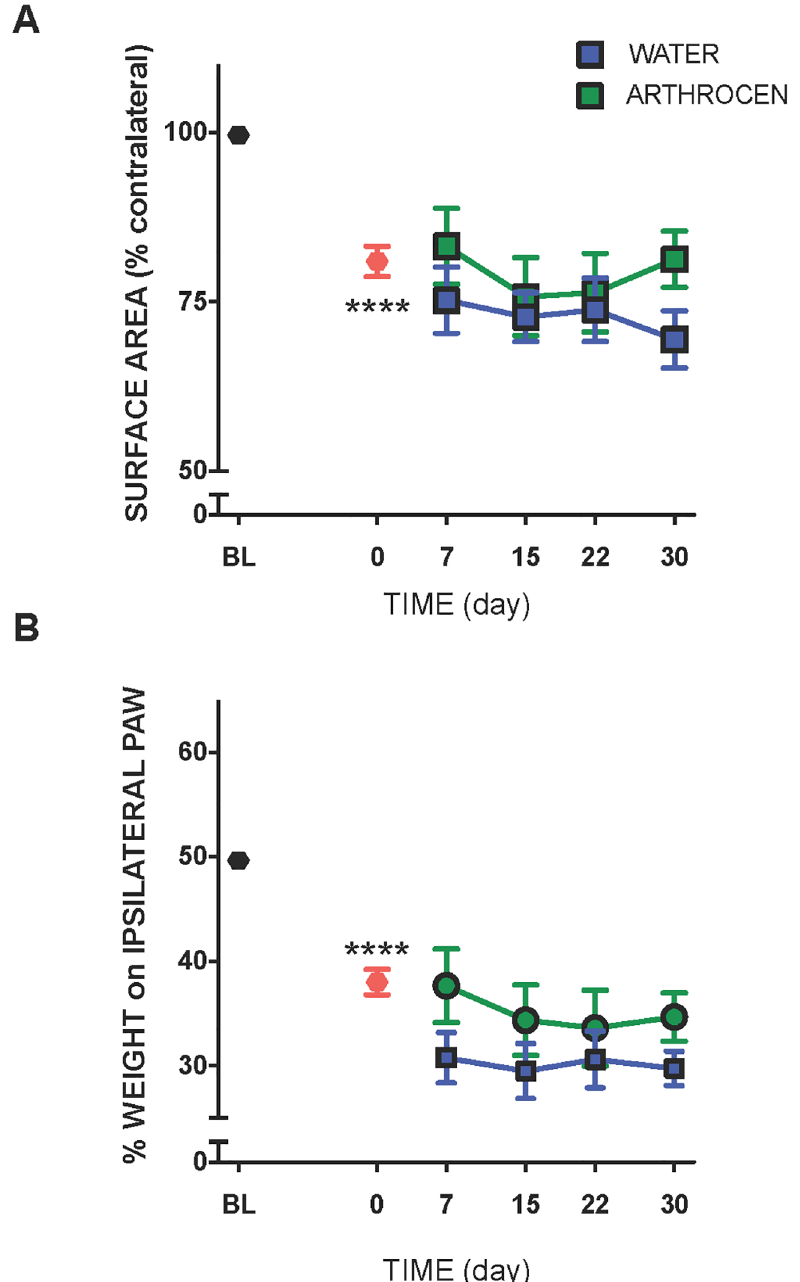
Fig 2. Effect of Arthrocen on hindpaw contact area (A) and hindlimb weight bearing (B) in OA animals. While the extent of hindpaw contact area was unaffected by Arthrocen treatment, the total amount of weight borne by the ipsilateral hindlimb increased over the duration of the treatment period. (cid:3)(cid:3)(cid:3)(cid:3) P < 0.0001compared to baseline. Data are presented as means ±S.E.M. ( n = 9–11).